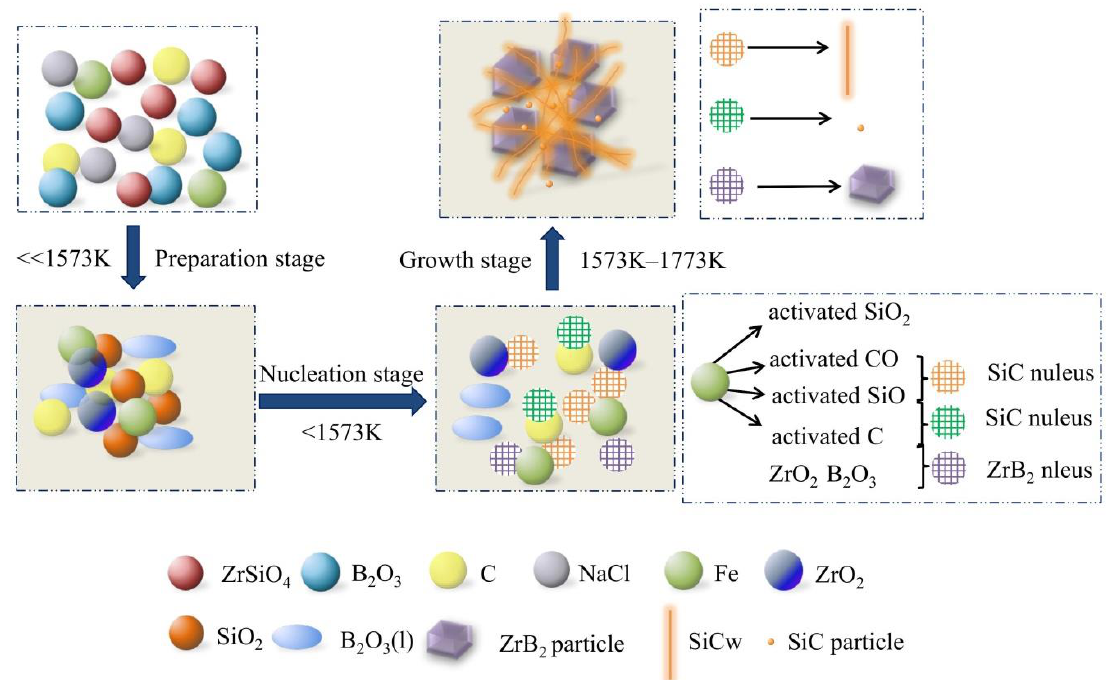
Figure 7. Illustrations of the possible growth process of SiC whiskers in the synthesis of ZrB 2 -SiC composite powders. composite